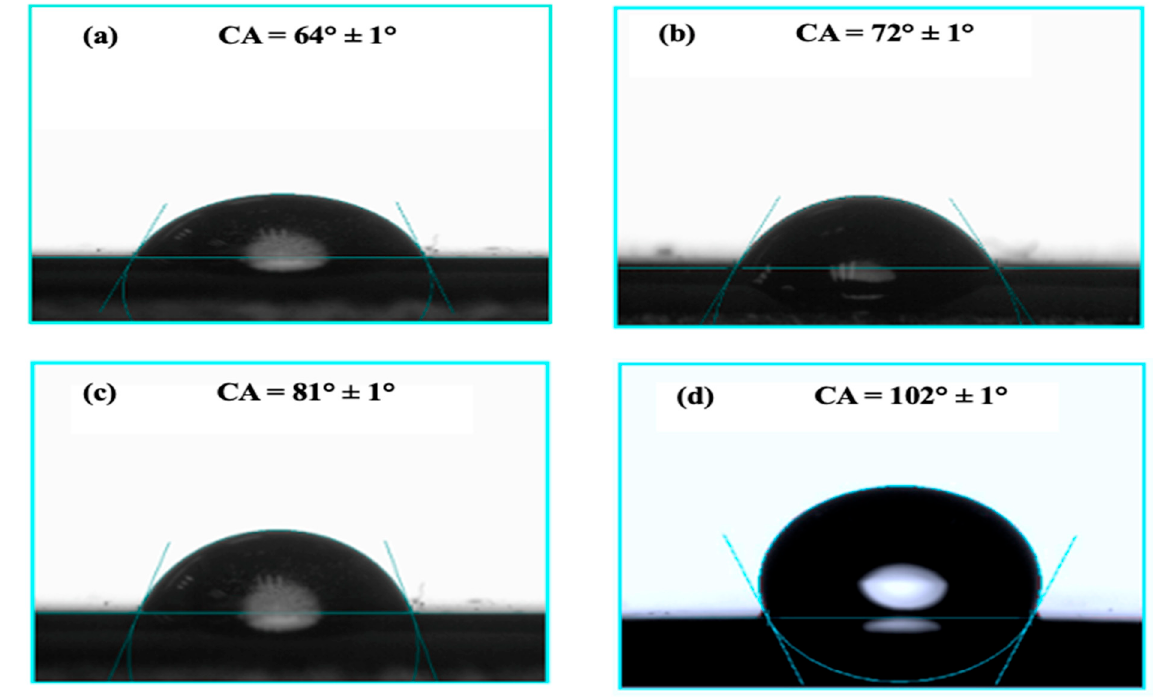
Figure 6. Surface contact angle of ( a ) neat epoxy, ( b ) X50 Gnp/epoxy, ( c ) M15 Gnp/epoxy, and ( d ) C750 Gnp/epoxy coatings.